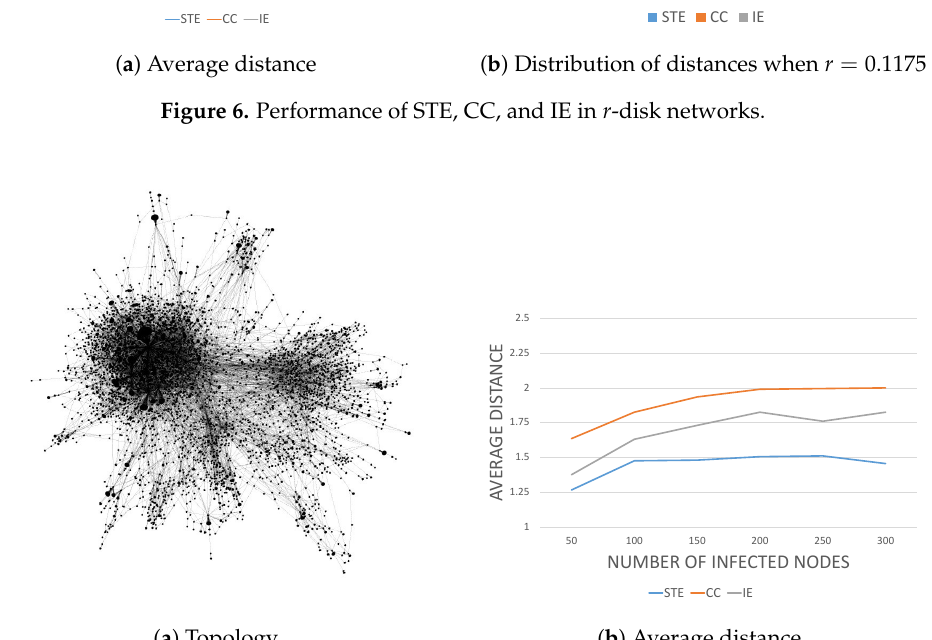
Figure 7. Detection performance in the Internet Autonomous System (IAS) network.